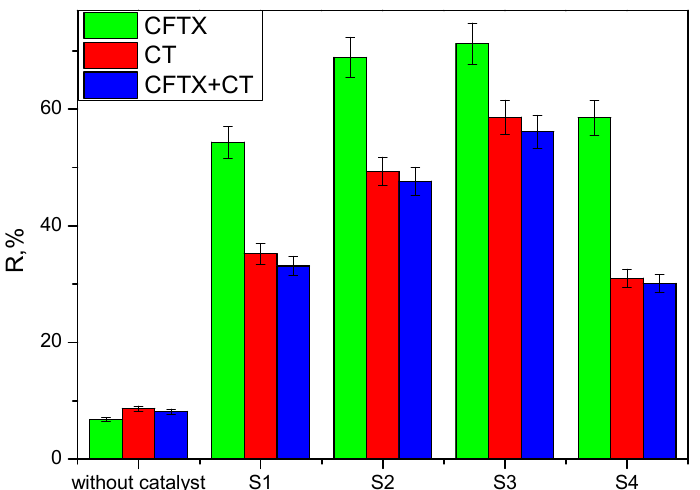
Figure 9. Degradation level for CFTX (ceftriaxone), CT (chlortetracycline) CFTX + CT (ceftriaxone+ chlortetracycline).